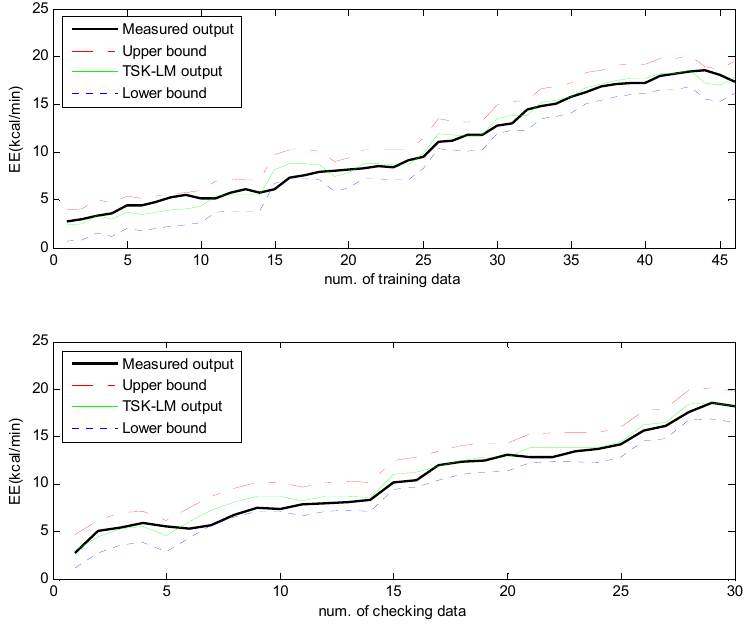
Figure 8. Approximation and generalization capability with interval prediction for training and checking